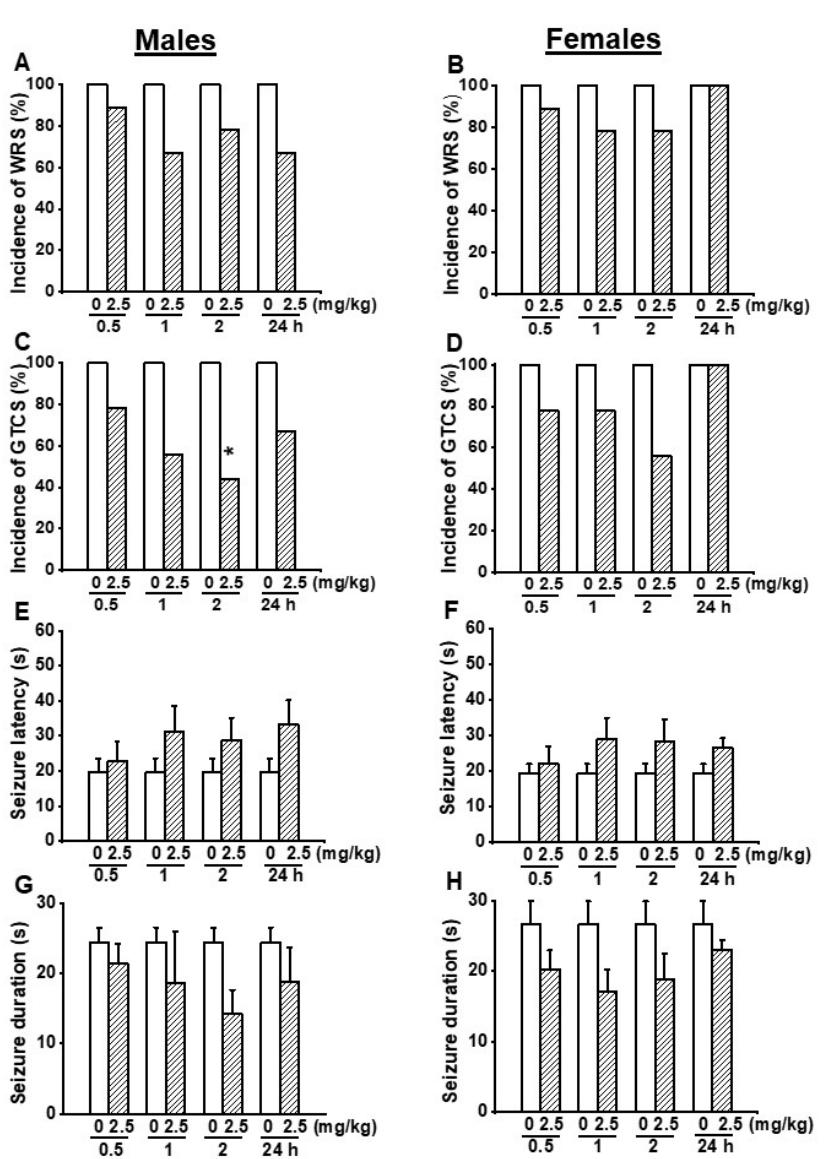
Figure 1. Effects of acute EACT treatment at the dose of 2.5 mg/kg on acoustically evoked seizures. The putative seizure suppressive effects EACT, a potent activator of TMEM16A, were evaluated at different post-treatment time points of 0.5, 1, 2, and 24 h in adult male ( n = 9) and female ( n = 9) GEPR-3s. ( A ) EACT treatment did not considerably reduce the incidence of the occurrence of WRSs in males. ( B ) Similarly, EACT treatment also did not considerably reduce the incidence of the occurrence of WRSs in females. ( C ) EACT treatment significantly reduced the incidence of the occurrence of GTCSs at the 2 h post-treatment time point in males. ( D ) However, EACT treatment did not considerably reduce the incidence of the occurrence of GTCSs in females. ( E ) EACT treatment did not considerably delay the seizure latency in males. ( F ) Similarly, EACT treatment also did not considerably delay the seizure onset in females. ( G ) EACT treatment did not considerably reduce the seizure duration in males. ( H ) Similarly, EACT treatment also did not considerably reduce the seizure duration in females. Data from the incidence of the occurrence of WRSs and GTCSs were represented as a mean percentage (%), and the Fisher Exact test was used for analysis. Data from the seizure latency and duration were presented as mean ± S.E.M., and one-way ANOVA followed by Bonferroni correction was used for analysis. Opened and filled bar graphs represent control-treated (pre-EACT) and EACT-treated GEPR-3s, respectively. * p <